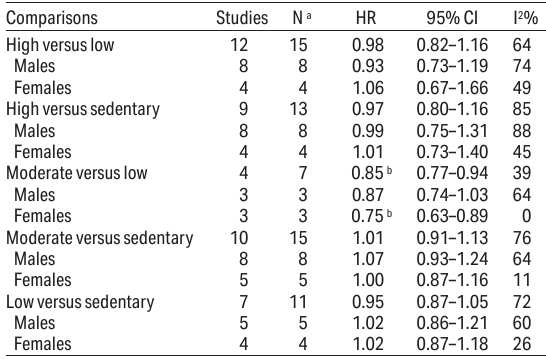
Table 2. Sensitivity analyses. Meta-analyses depicting the association between occupational physical activity groups and cardiovascular disease mortality adjusting for confounders (at least age, gender and smoking and additional variables). [HR=hazard ratio; CI=confidence interval; I 2